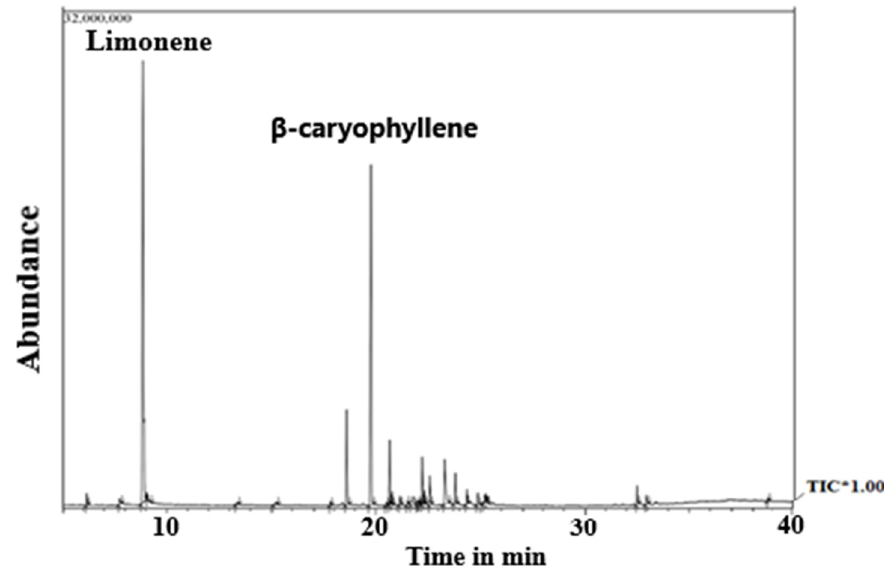
Figure 1. GC–MS chromatogram of PGLEO. Table 1. Volatile composition of the PGLEO by GC–MS analysis. Table 2. Antimicrobial activity of Psidium guajava